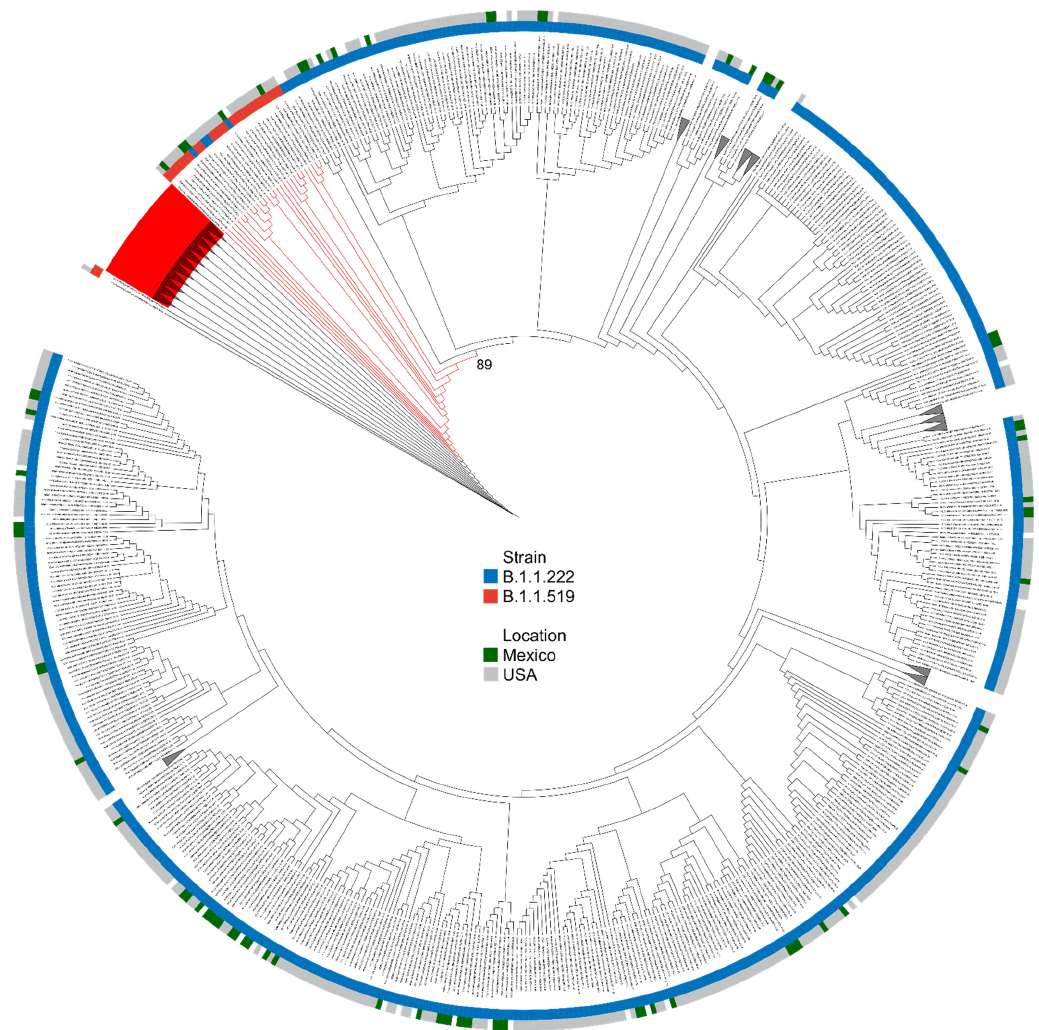
Figure 3. Phylogenetic relationships of SARS-CoV-2 B.1.1.222 and B.1.1.519 lineages. A maximum likelihood phylodynamic inference was done of 84 SARS-CoV-2 sequences from Mexico in a global background of 19312 sequences available in the GISAID EpiCoV database as of 1 May 2020. Leaves are colored according to their Pango lineage: B.1.1.519 (red) and B.1.1.222 (blue) and according to their geographical origin: Mexico (green) and USA (gray). The bootstrap value of the mixed cluster (described in the main text) is shown.